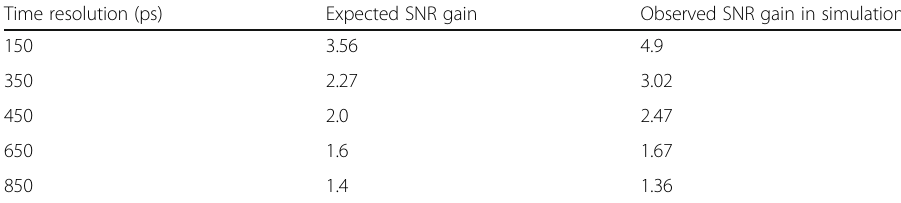
Table 3 The expected and observed SNR gains for an object with 27 cm diameter Time resolution